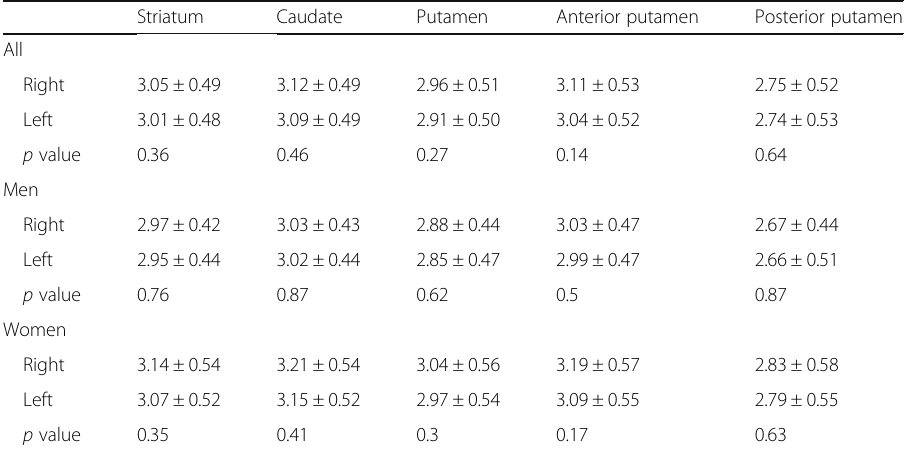
0.35 0.41 0.3 0.63 Values are mean±SD. The p value indicates the statistical significance between left and right SBRs (paired t test). SBRs specific binding